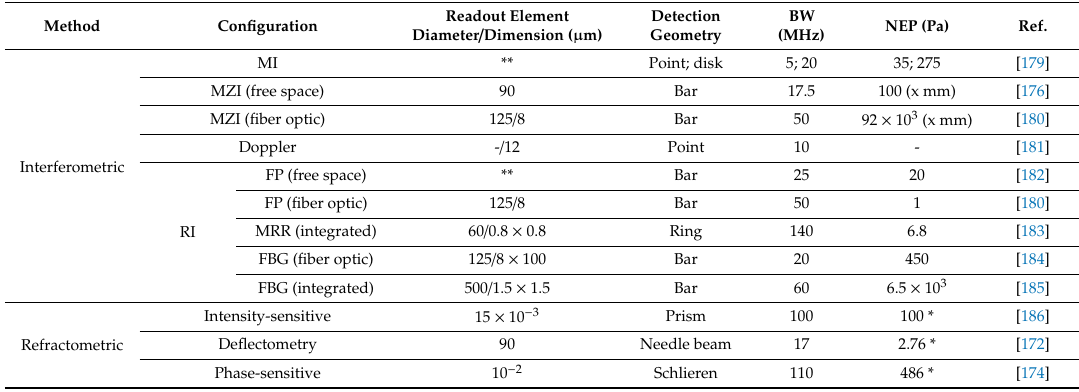
Table 6. Summary of the performances of di ff erent optical ultrasound detection techniques. Reproduced from